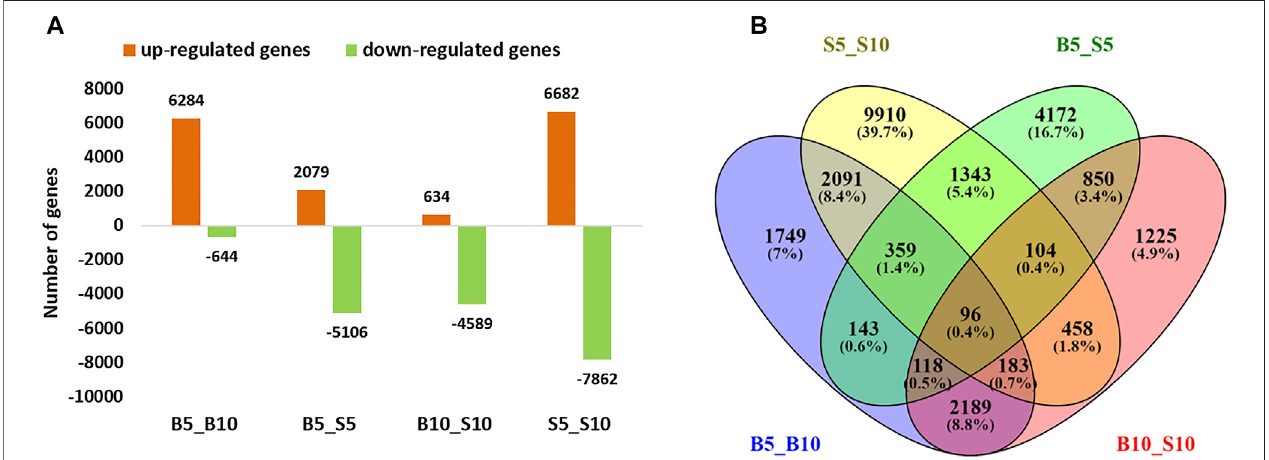
FIGURE3| Differentiallyexpressed genesinthetwogenotypesofricebeanattwotime points,i.e., 5and 10DPA. (A) Comparison ofDEGsrepresentingtheshare ofoverlappedandnon-overlappedtranscriptsinboldandsmallgenotypesat5and10DPA. (B) Numberofupregulatedanddownregulatedsigni fi cantgenesinboldand small genotypes.